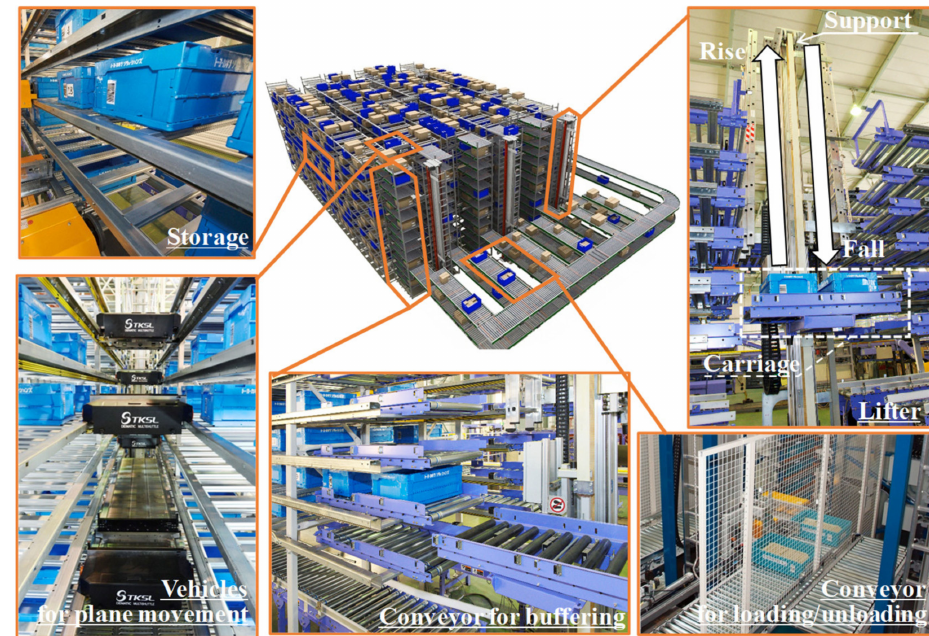
Figure 1. Overview of the entire logistics